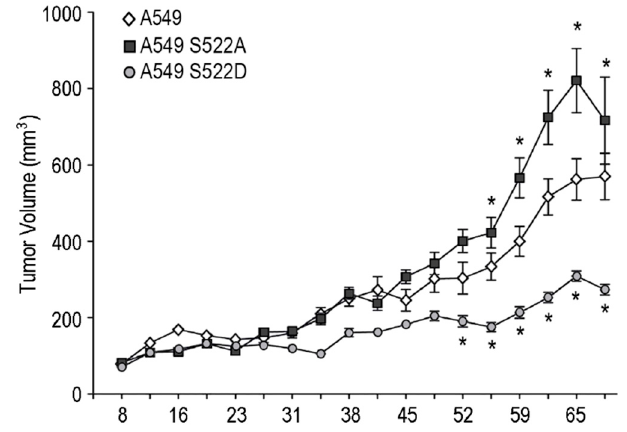
Figure 8. A549 lung carcinoma cells expressing CRMP2 phosphomimetic mutants originate smaller tumors than wild type cells. Tumor growth in nude athymic female mice subcutaneously injected with the control cell line A549 and the A549 S522 clones. Tumor size was measured every 3–4 days. Data are shown as the volume of the primary tumors, calculated as V = (length 2 + width)/2. * ( p < 0.05).